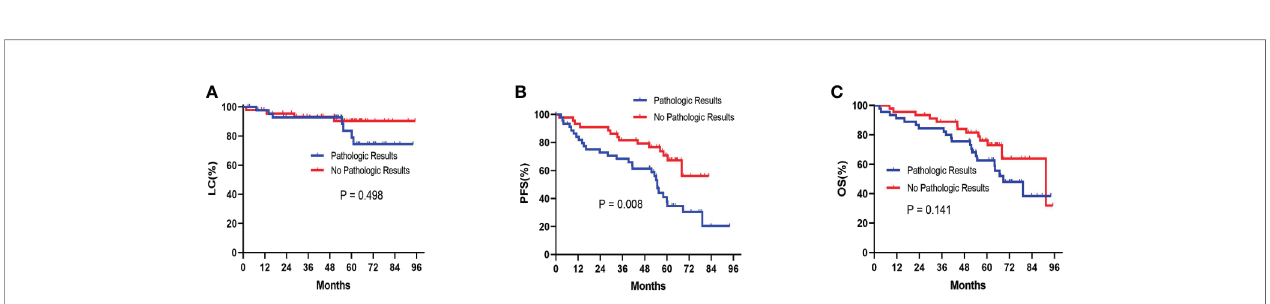
FIGURE 3 | Kaplan-Meier survival analysis after the PSM analysis for LC (A) , PFS (B) , and OS (C) between patients with pathologic results and patients with no pathologic results. PSM, propensity score matching; LC, local control; PFS, progression-free survival; OS, overall survival.